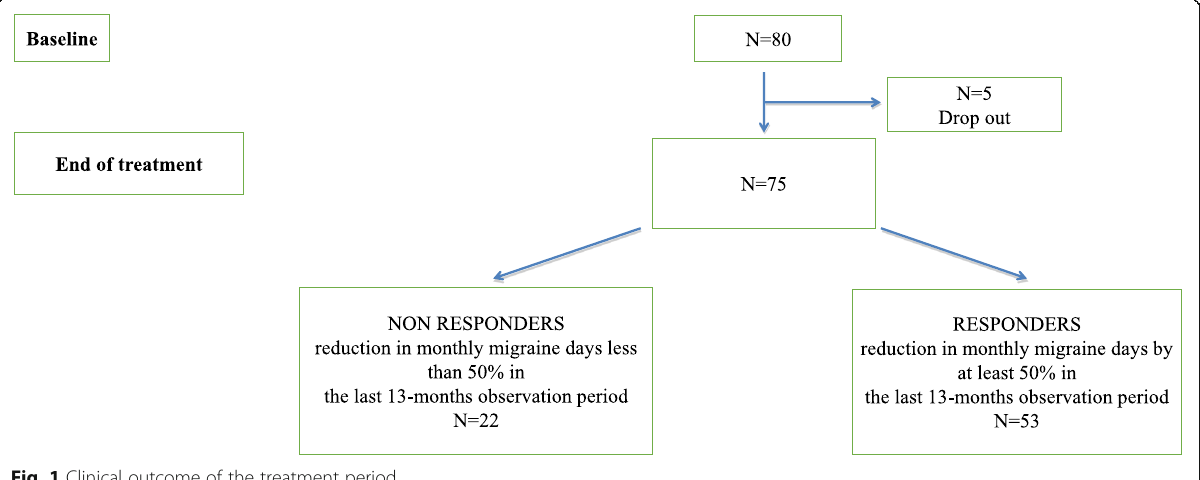
Fig. 1 Clinical outcome of the treatment